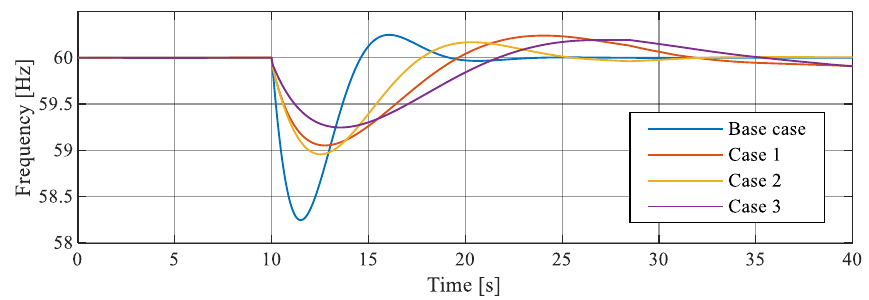
Figure 11. Grid-frequency response to a sub-frequency event.